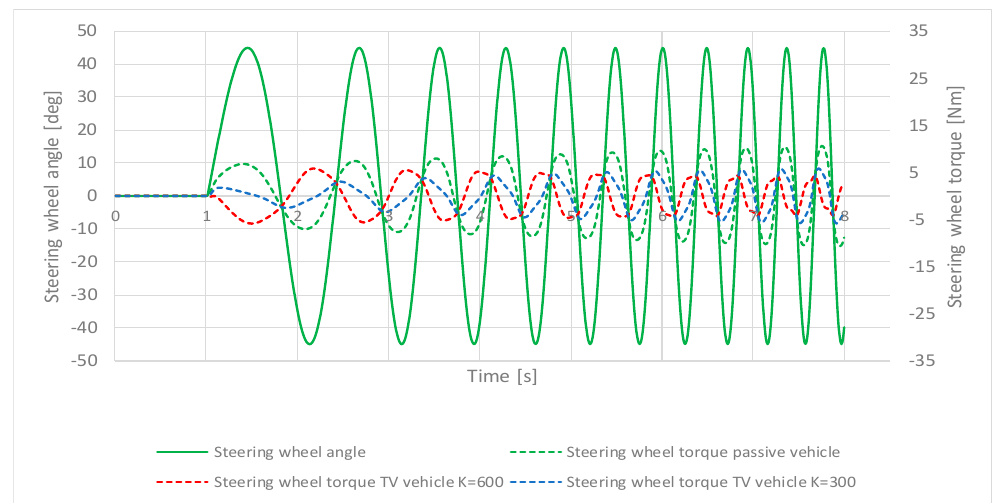
Figure 14. Steering wheel: angle and torque for passive vehicle (green) and TV vehicle (blue k = 300, red k = 600).